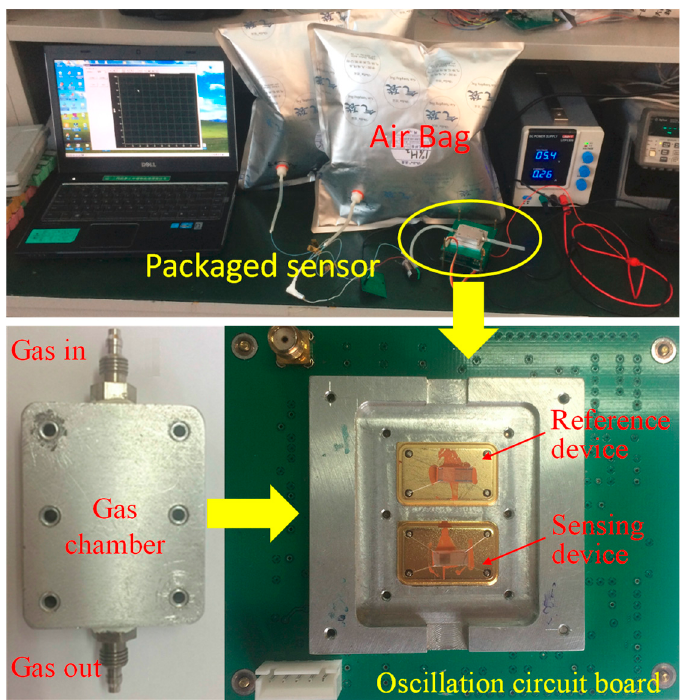
Figure 2. The experimental setup for characterizing the prepared sensing devices.